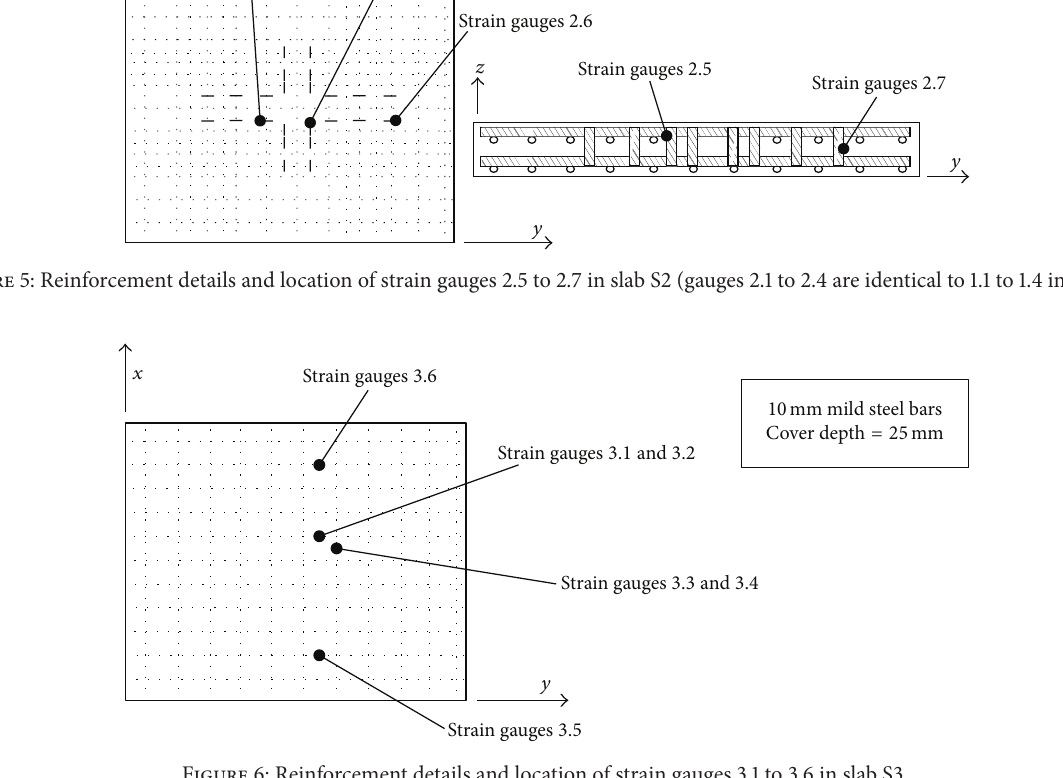
Figure 6: Reinforcement details and location of strain gauges 3.1 to 3.6 in slab